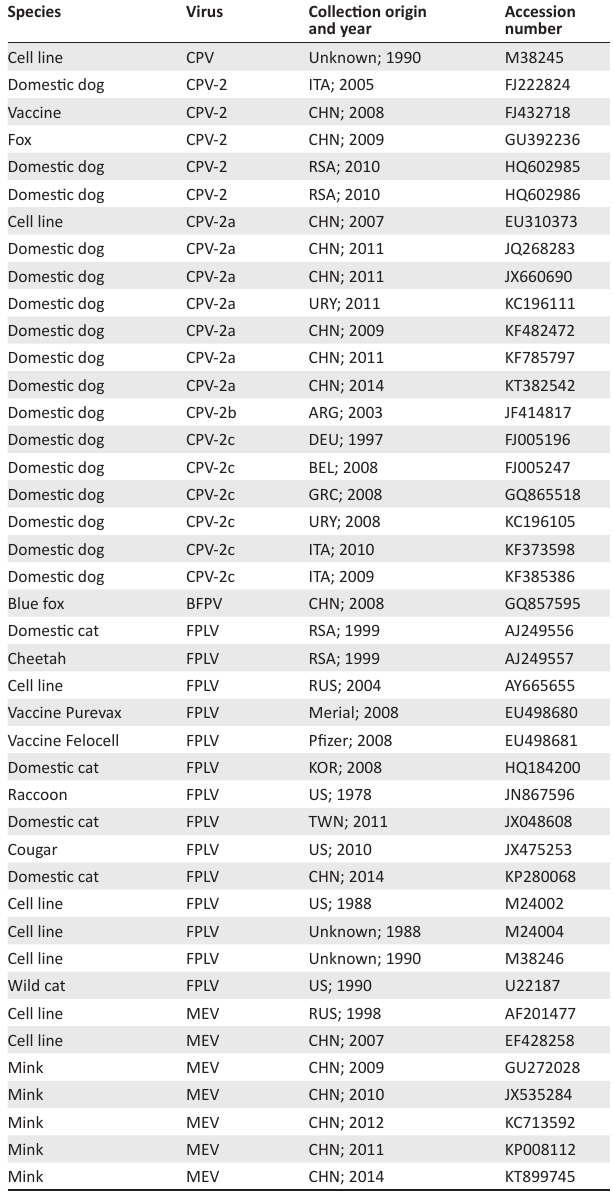
TABLE 3: GenBank reference sequences including species, country of origin, year of collection and accession